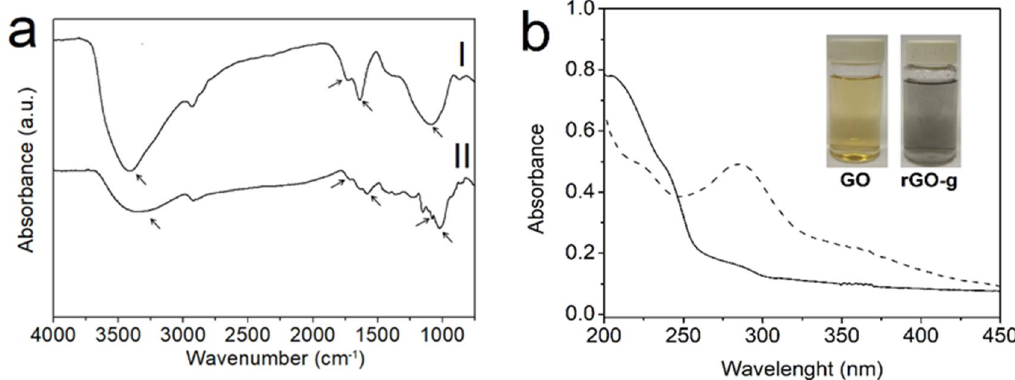
Figure 1. ( a ) FTIR spectra for GO (trace I) and rGO-g (trace II). ( b ) UV-vis absorption spectra for GO (continuous line) and rGO-g (dashed line) dispersions, photographs of GO and rGO-g sonicated solutions at 0.01 g/L.